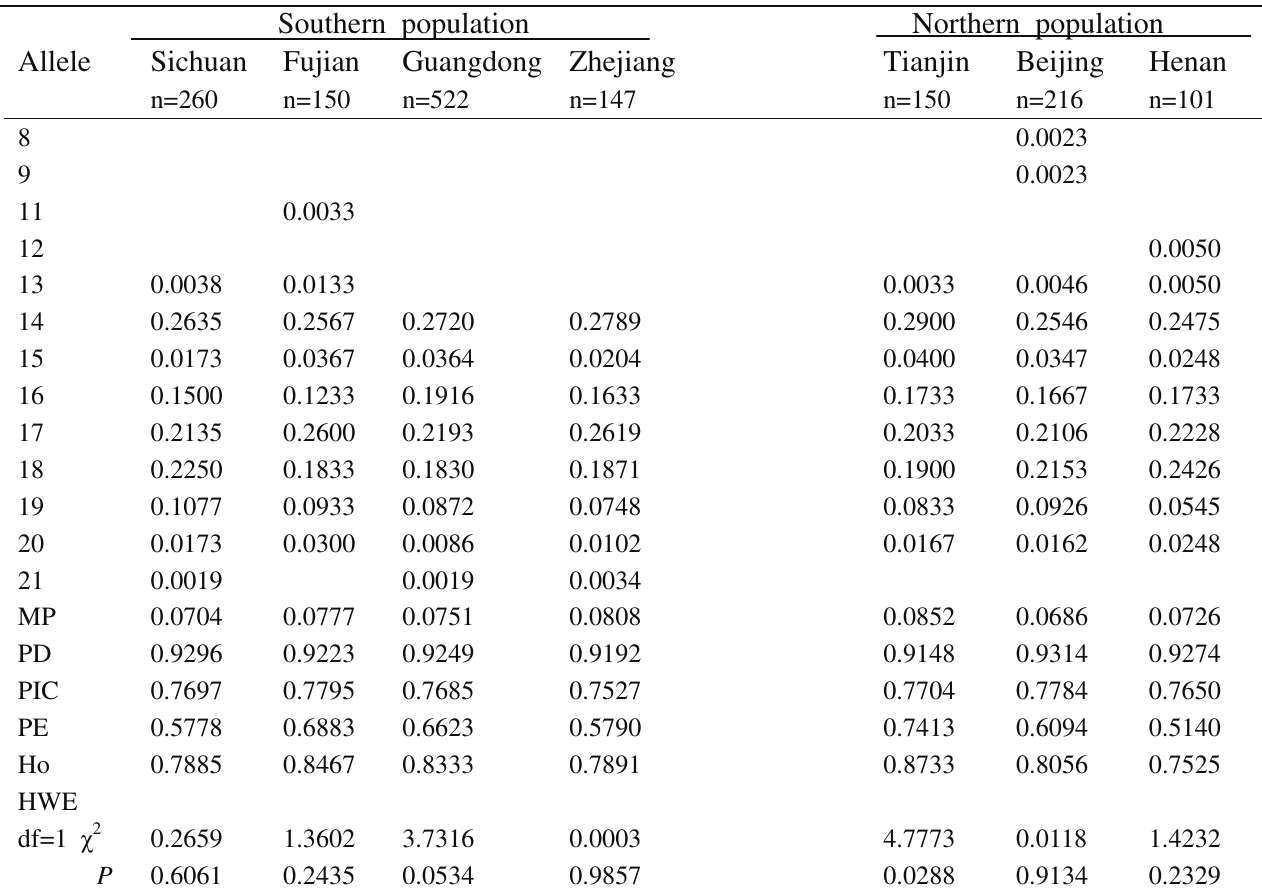
Table S7- Genetic polymorphism at the VWA locus for the seven Chinese population